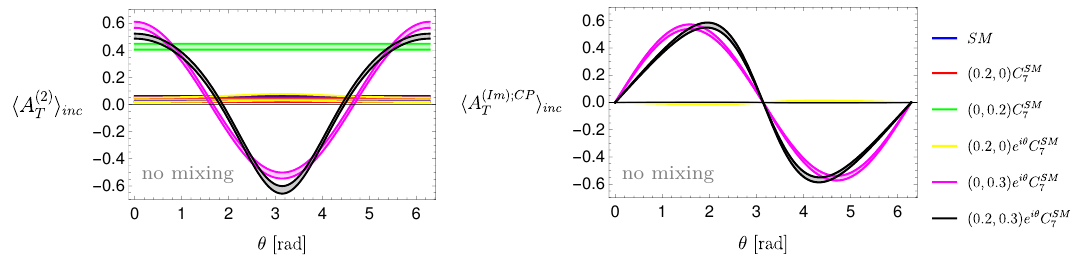
Figure 6 . Variation with the NP weak phase of h A (2) [0 . 0008 , 0 . 257] GeV 2 . For comparison, the selected NP scenarios are shown without taking into account meson-mixing